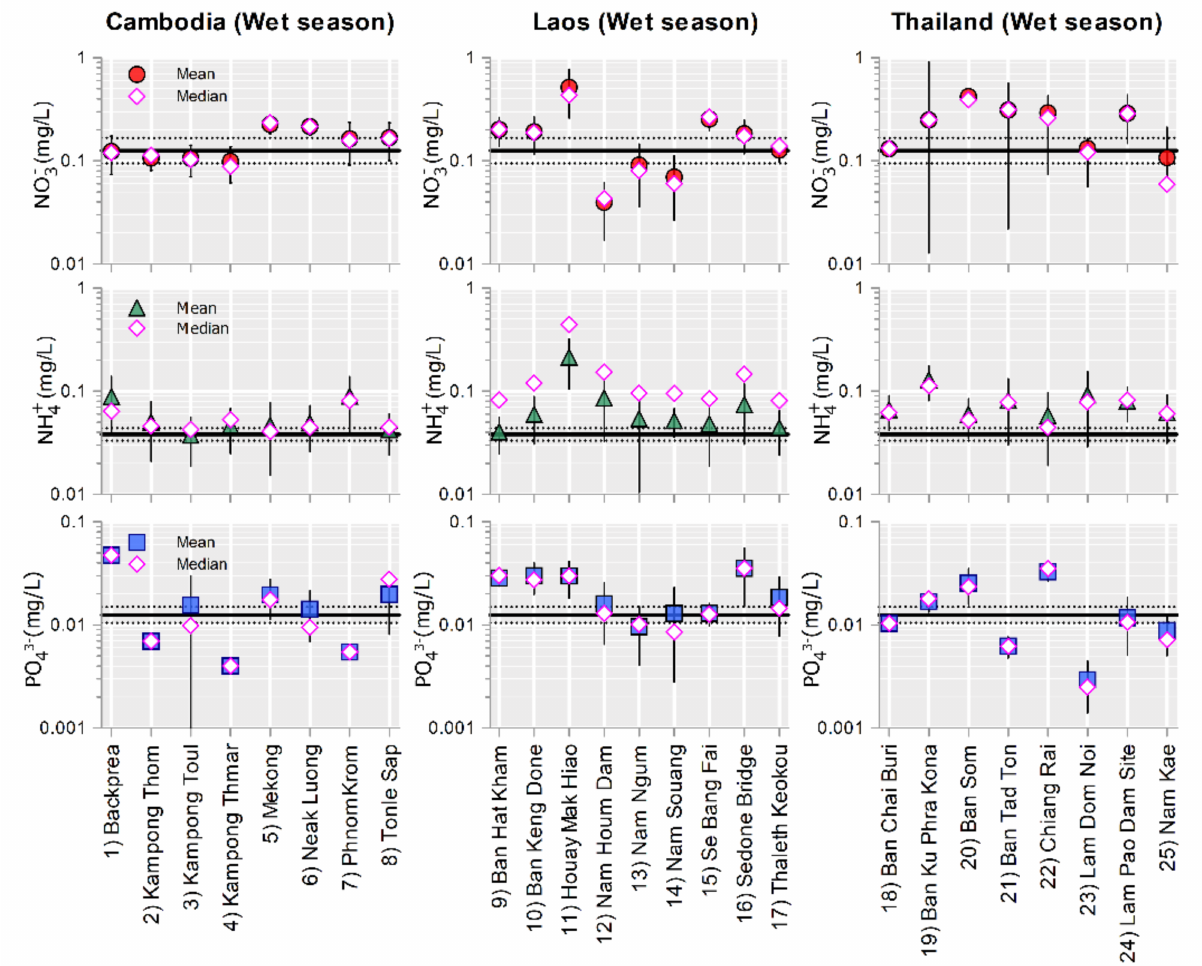
Figure 6. Mean NO 3 − , NH 4+ , PO 43 − concentrations for the wet season in Cambodia, Laos, and Thai land. Black horizontal lines report reference values and dotted lines correspond to the 95% confidence